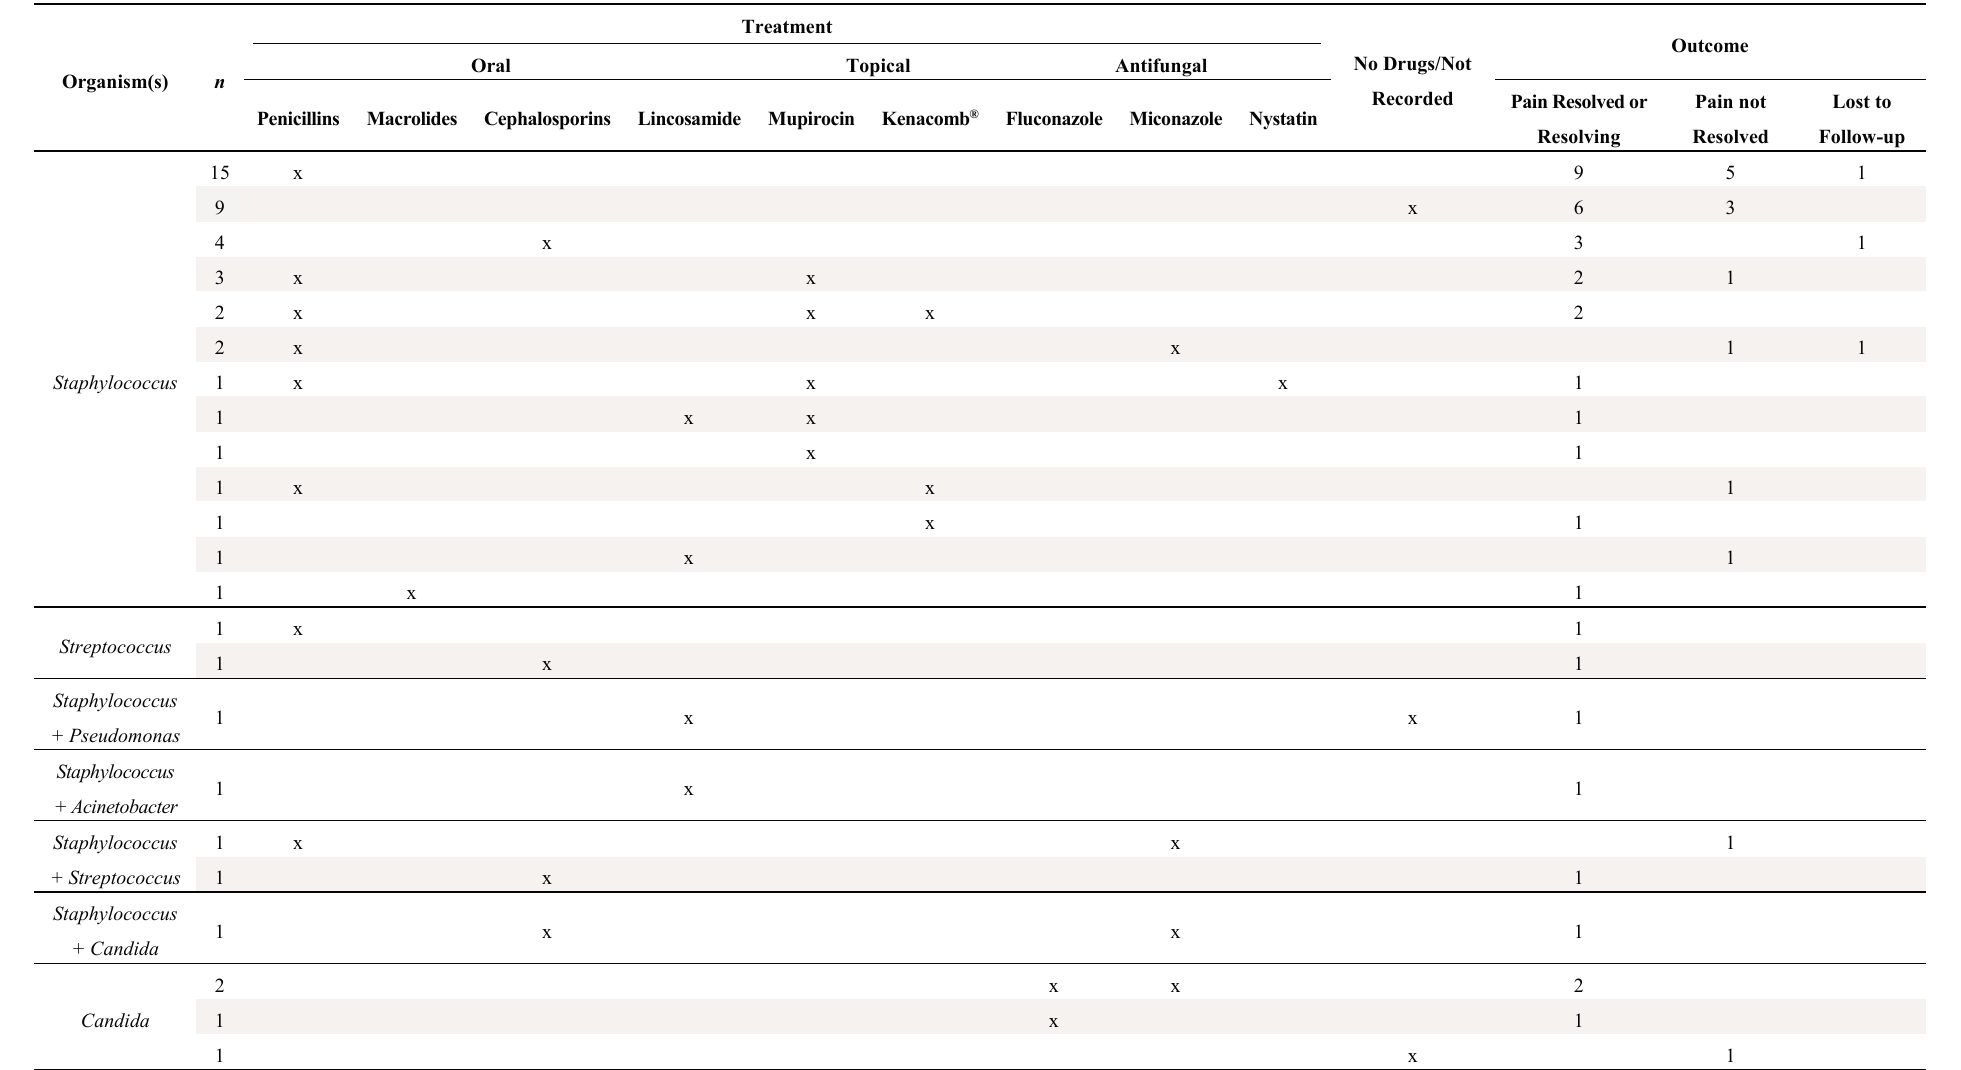
Outcome No Drugs/Not Recorded Pain Resolved or Pain not Lost to Resolving Resolved Follow-up